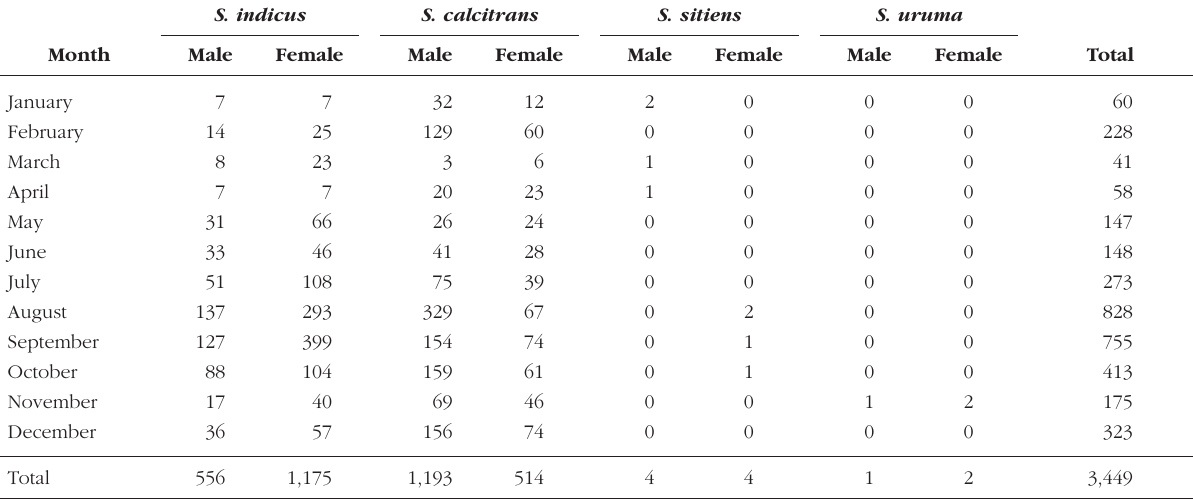
Table III. – Monthly captures of Stomoxyine flies ( Stomoxys spp.) with Vavoua traps (16 day-traps per month) at Wang Nam Khiao District, Nakhon Ratchasima Province, Thailand (from January to December 2010).